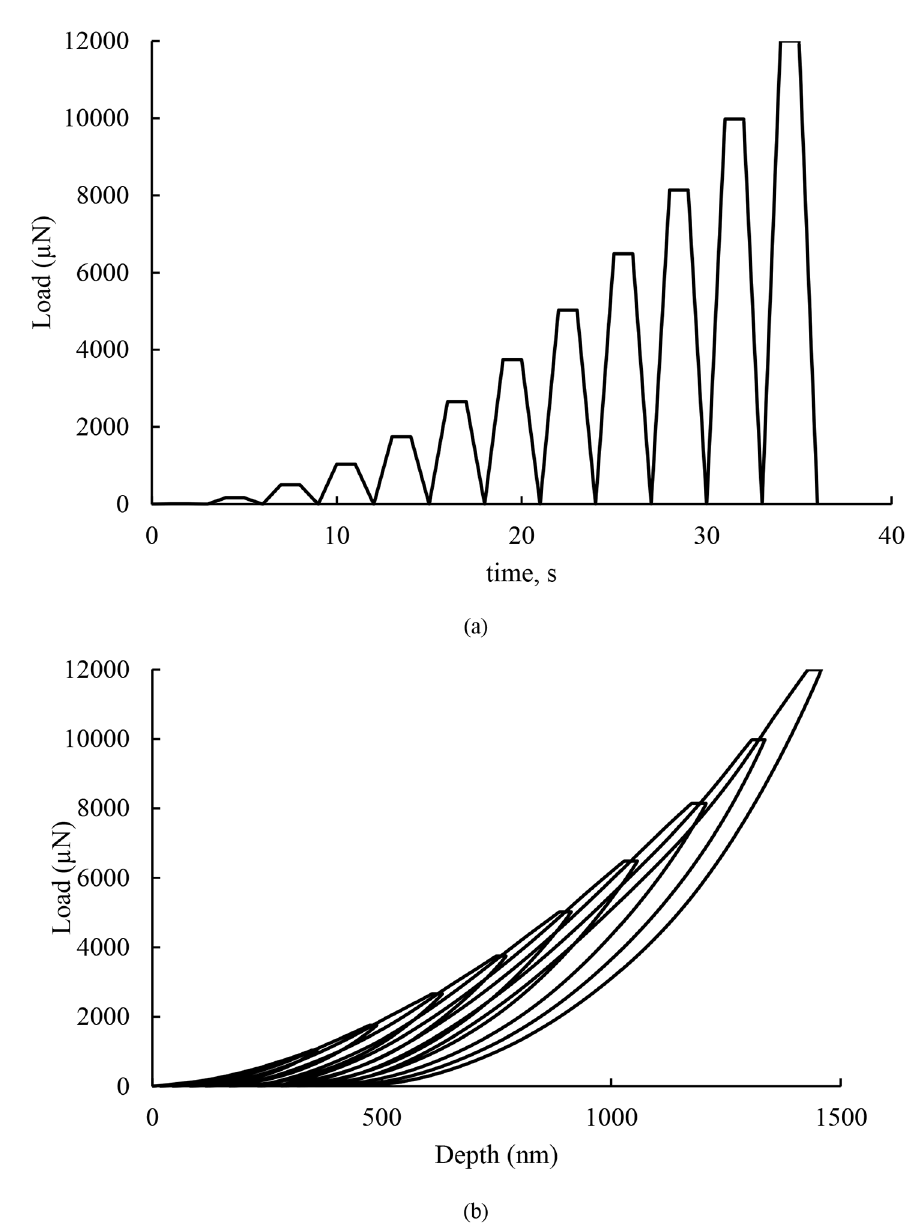
Fig. 1 a Loading mode for the cyclic nanoindentation b Example of P - h curve for cyclic nanoindentation (coal No.